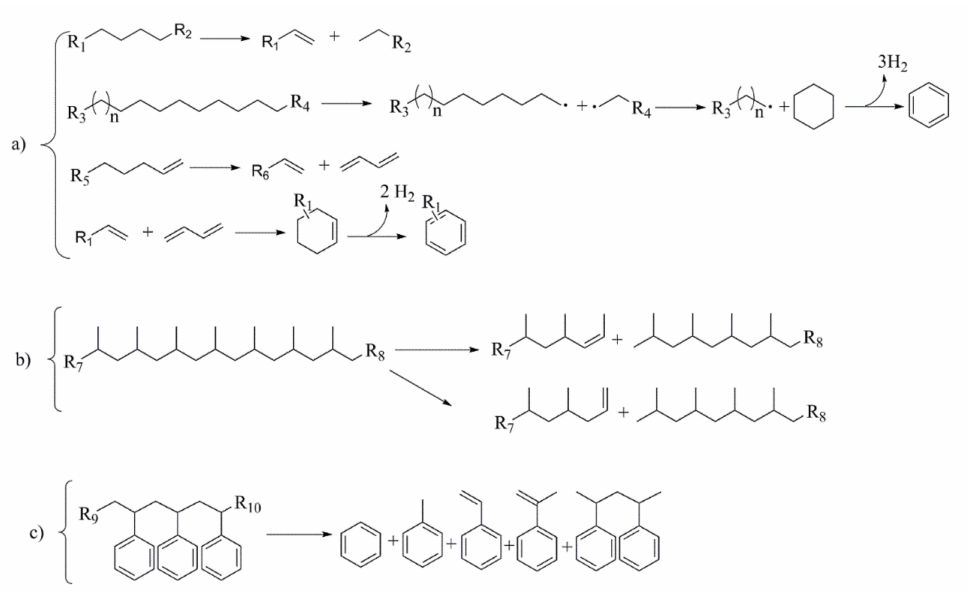
Figure 6. Radical degradation routes of ( a ) poly(ethylene), ( b ) poly(propylene), and ( c ) poly(styrene) under pyrolytic